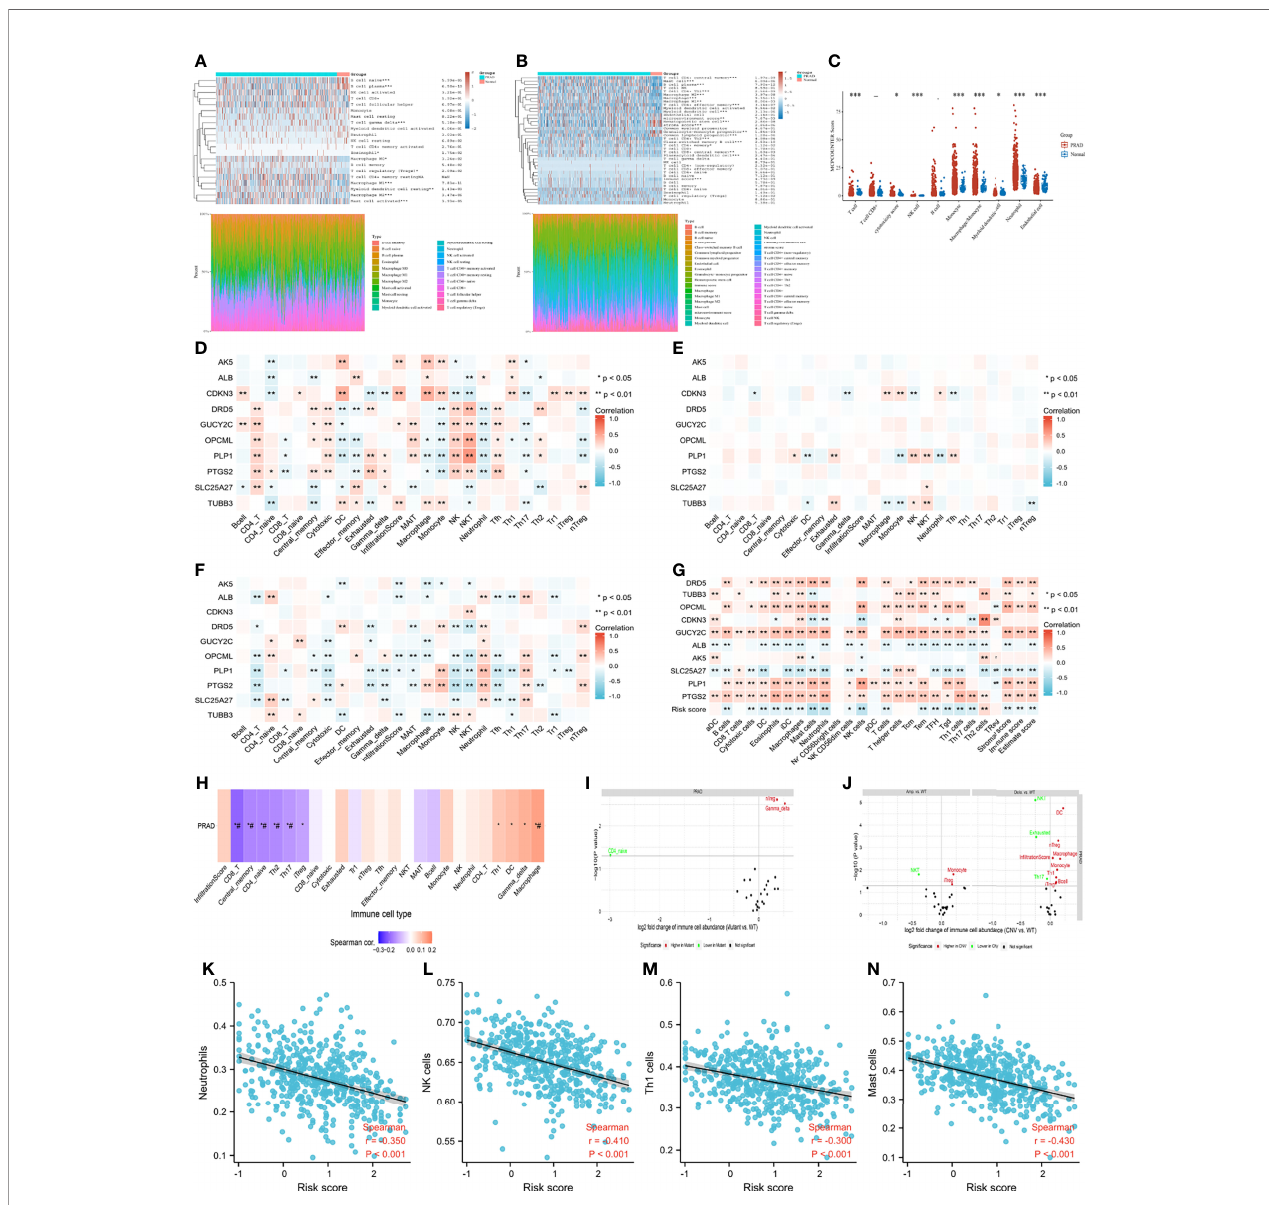
FIGURE 7 | Tumor immune microenvironment. (A) immune in fi ltration estimations using CIBERSORT algorithm; (B) immune in fi ltration estimations using Xcell algorithm; (C) immune in fi ltration estimations using MCP-counter algorithm; (D) the correlation between gene mRNA expression and immune cells; (E) the correlation between gene CNV and immune cells; (F) the correlation between gene methylation and immune cells; (G) the correlation between gene mRNA expression and immune cells using ssGSEA algorithm; (H) the correlation between gene set GSVA scores and immune cells; (I) the correlation between gene set SNV and immune cells; (J) the correlation between gene set CNV and immune cells; (K) the correlation between risk score and neutrophils; (L) the correlation between risk score and natural killer (NK) cells; (M) the correlation between risk score and T helper type 1 cells; (N) the correlation between risk score and mast cells. ##: false discovery rate ≤